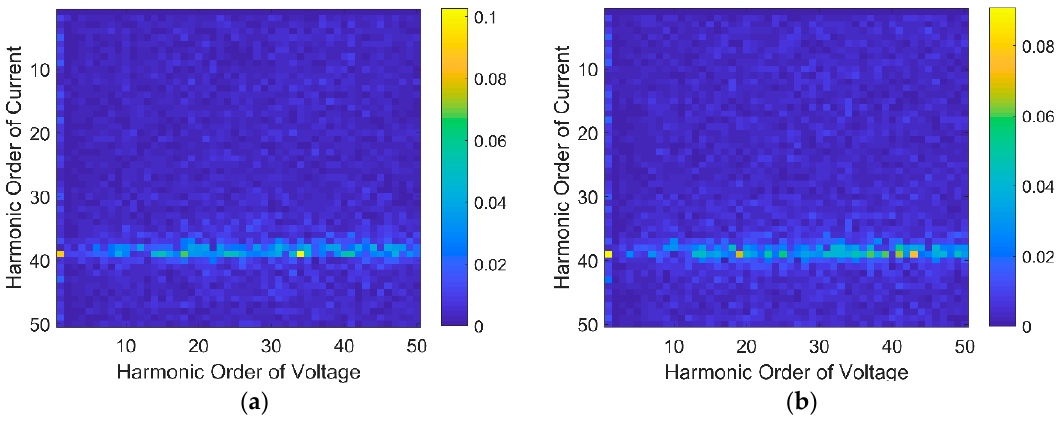
Figure 9. Magnitude of estimated admittance model Y + ( a ) and Y − ( b ), with unit Ohms.